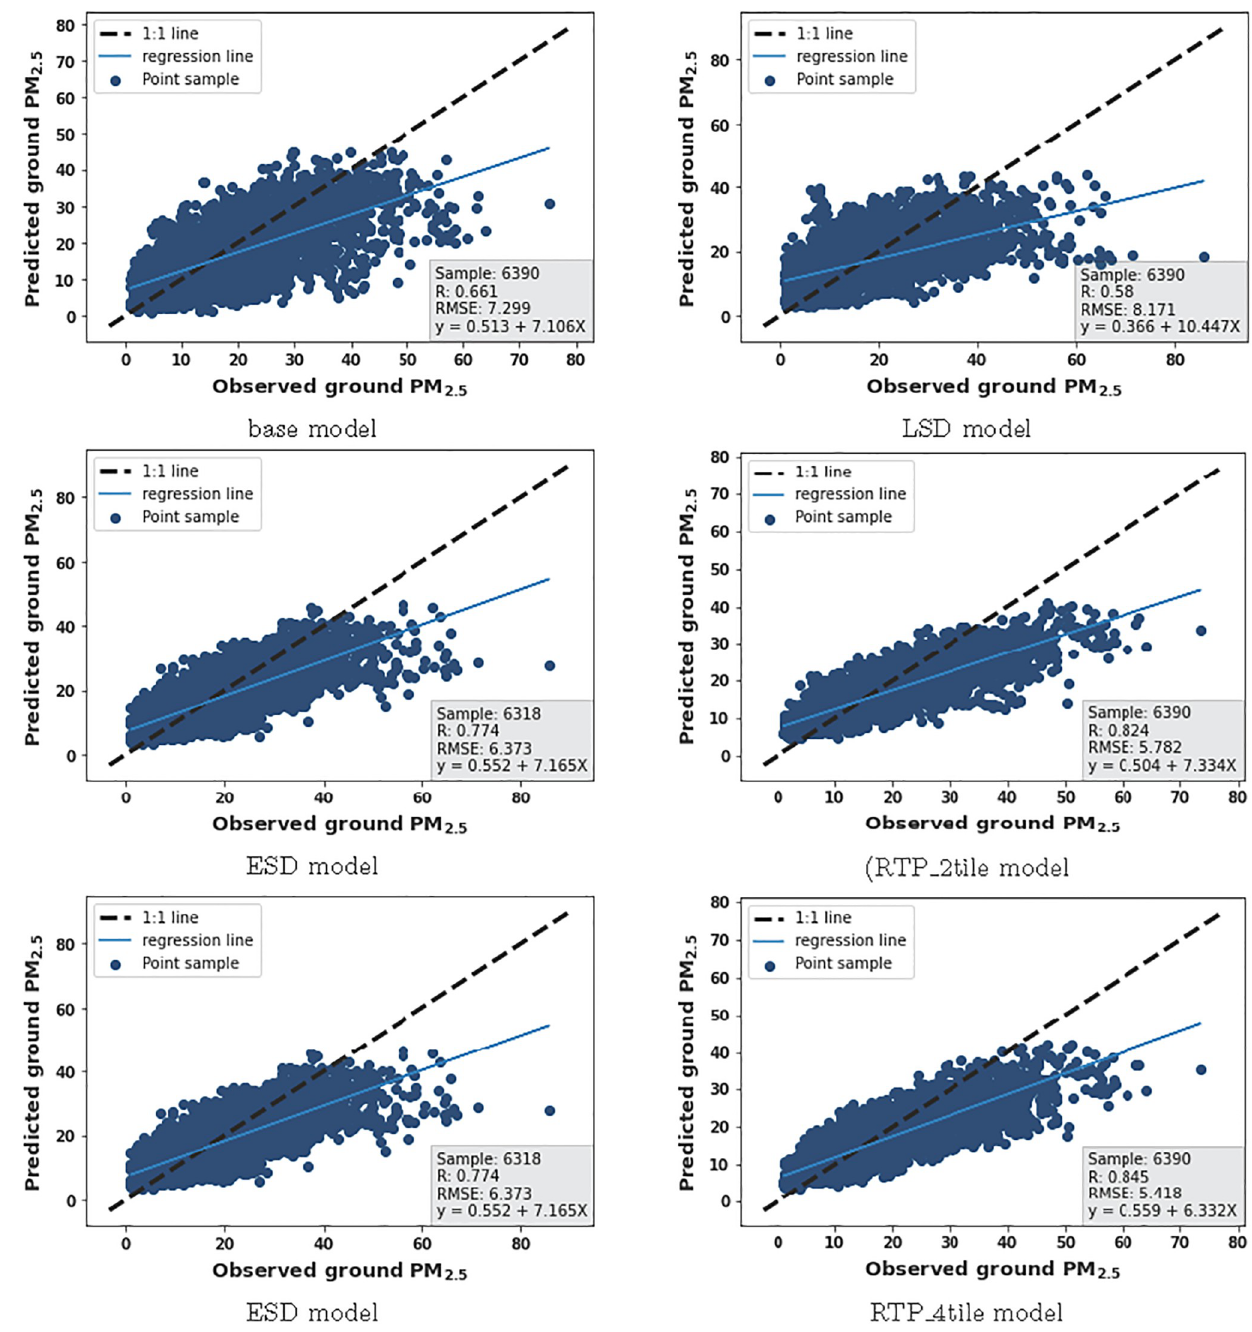
Fig 6. Observed PM 2.5 vs predicted PM 2.5 scatter graphs. Plots of association between observed PM 2.5 vs predicted PM 2.5 for Base model and proposal models for next 1 day prediction.